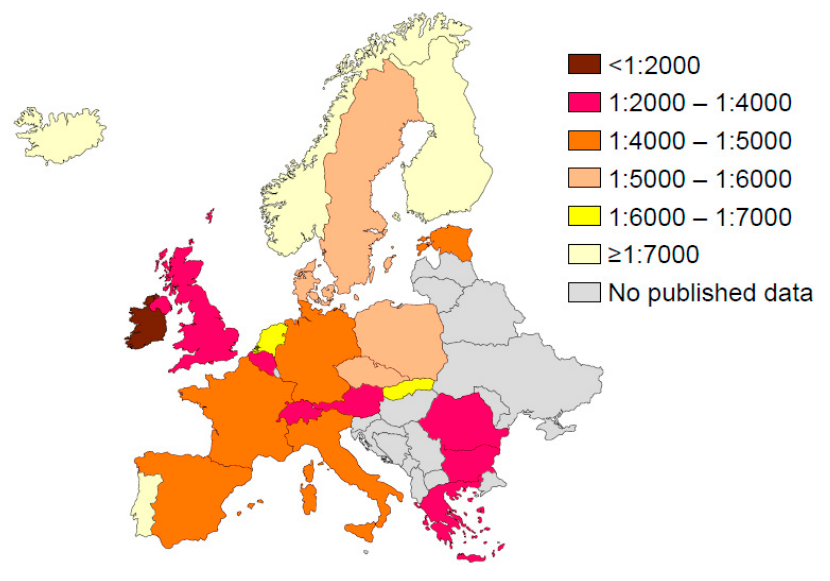
Figure 5. Incidence of cystic fibrosis in Europe.